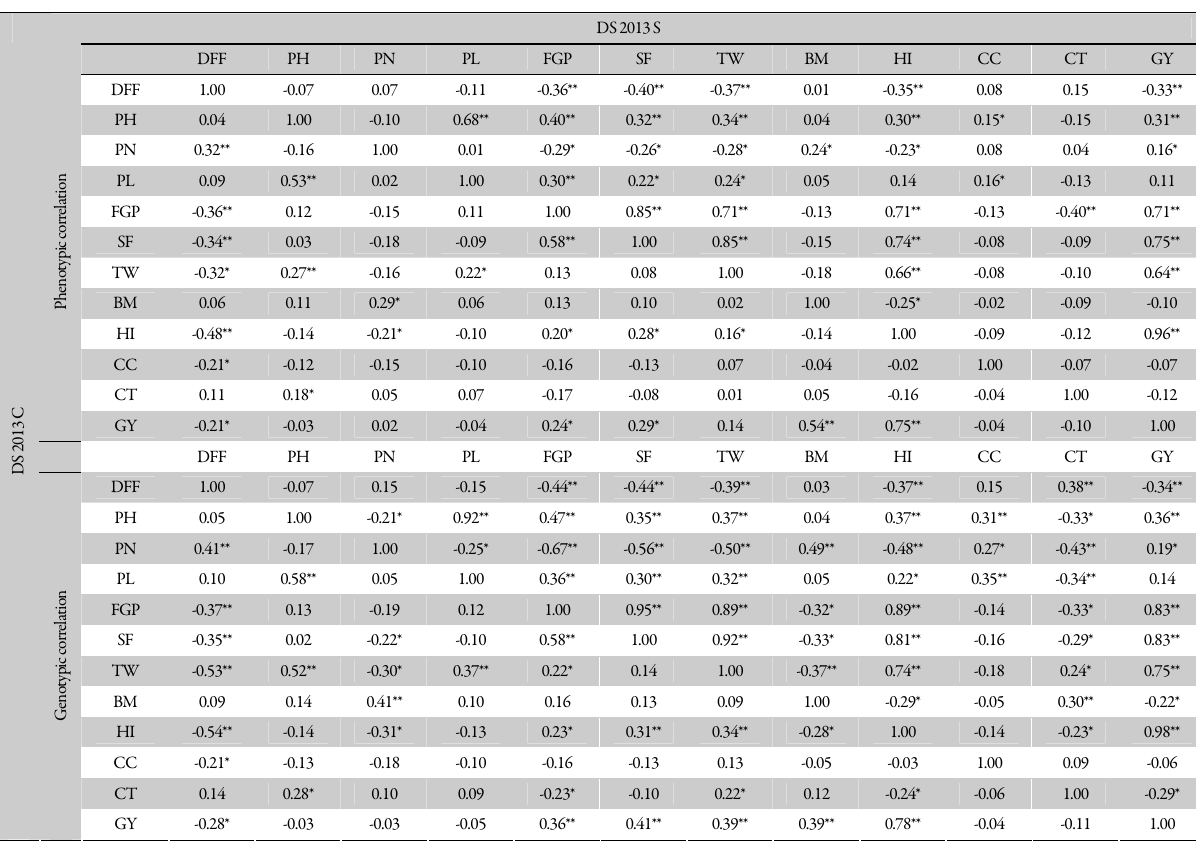
Tab. 3a. Phenotypic and genotypic correlation coefficients between yield and yield components traits of the